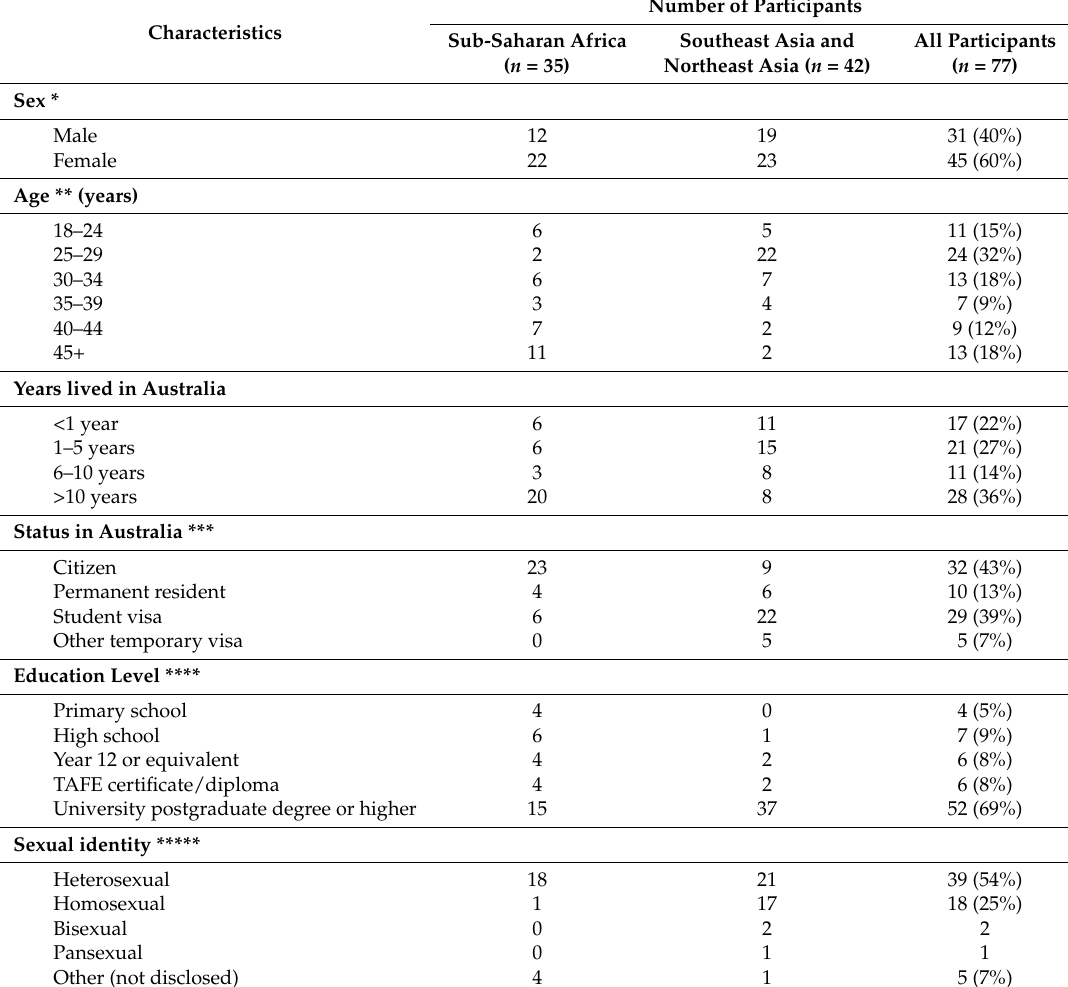
Table 1. Socio-demographics of focus group participants by region of birth.